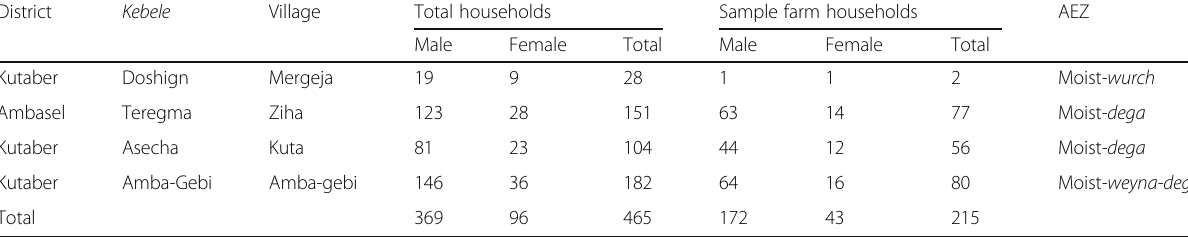
Table 1 Distribution of sample farm households by district and village level District Kebele